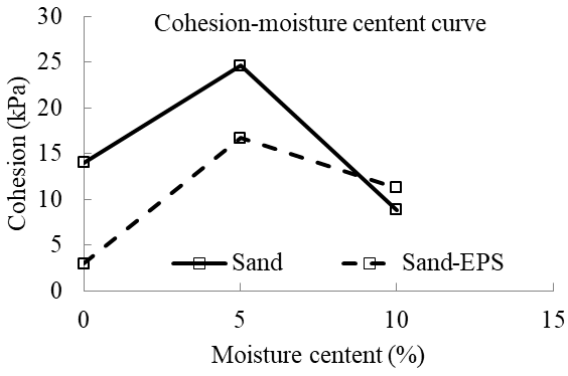
Figure 10. Cohesion – moisture curve Figure 10. Cohesion–moisture